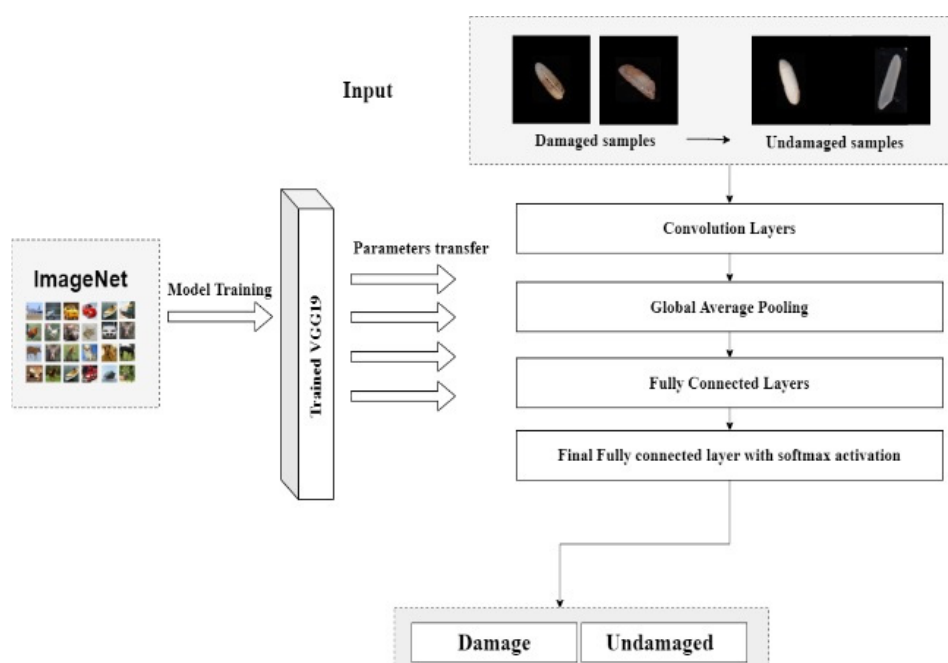
Figure 9. Process diagram of the transfer learning model VGG19.